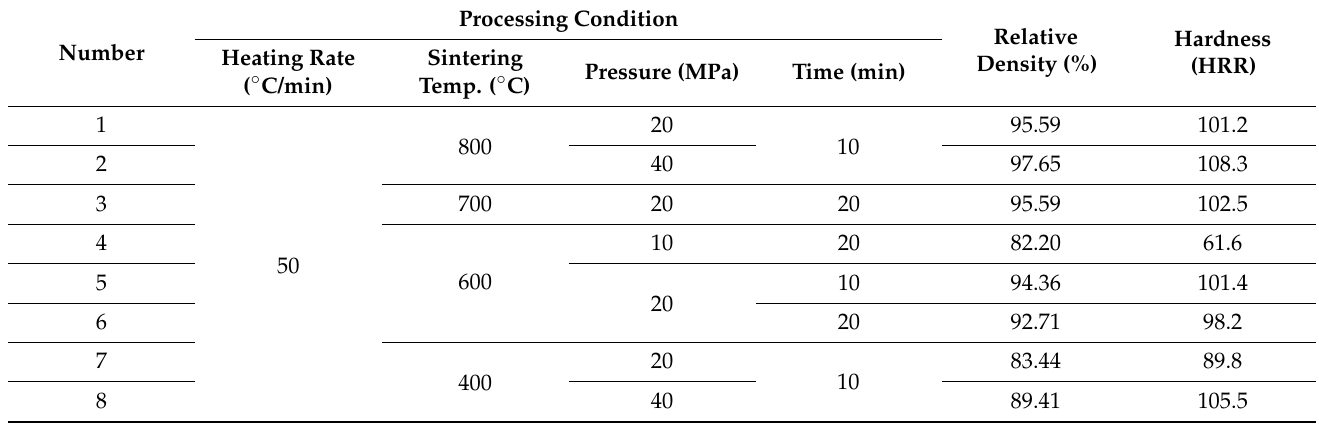
Table 1. Spark plasma sintering (SPS) conditions used in this study and relative densities and hardnesses of samples formed under different SPS